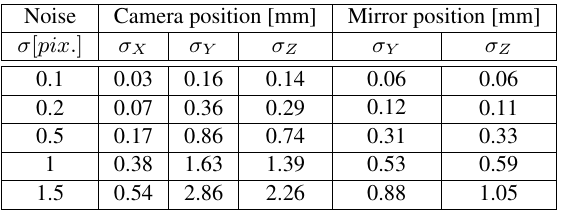
Table 1. Parameter accuracy measures as a function of the noise level, using random point distribution (Fig. 2a)